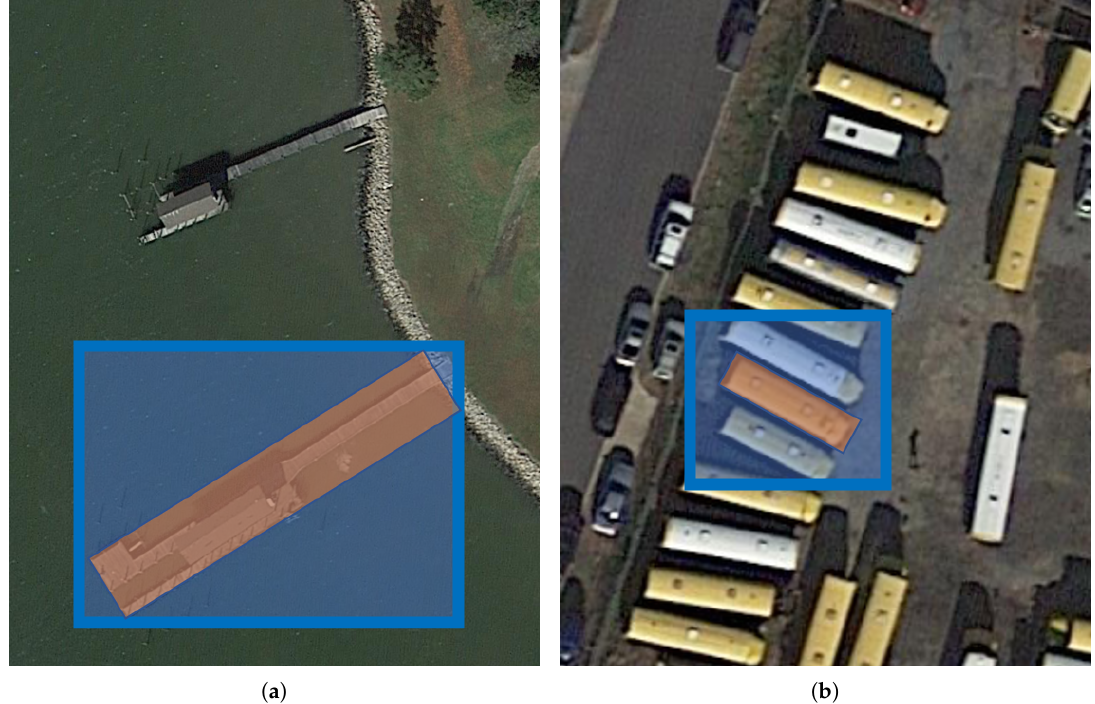
Figure 2. Examples of misalignment caused by ( a ) a background feature and ( b ) features from surrounding objects. In each example, the extracted feature(s) is highlighted in blue and the object feature is colored in